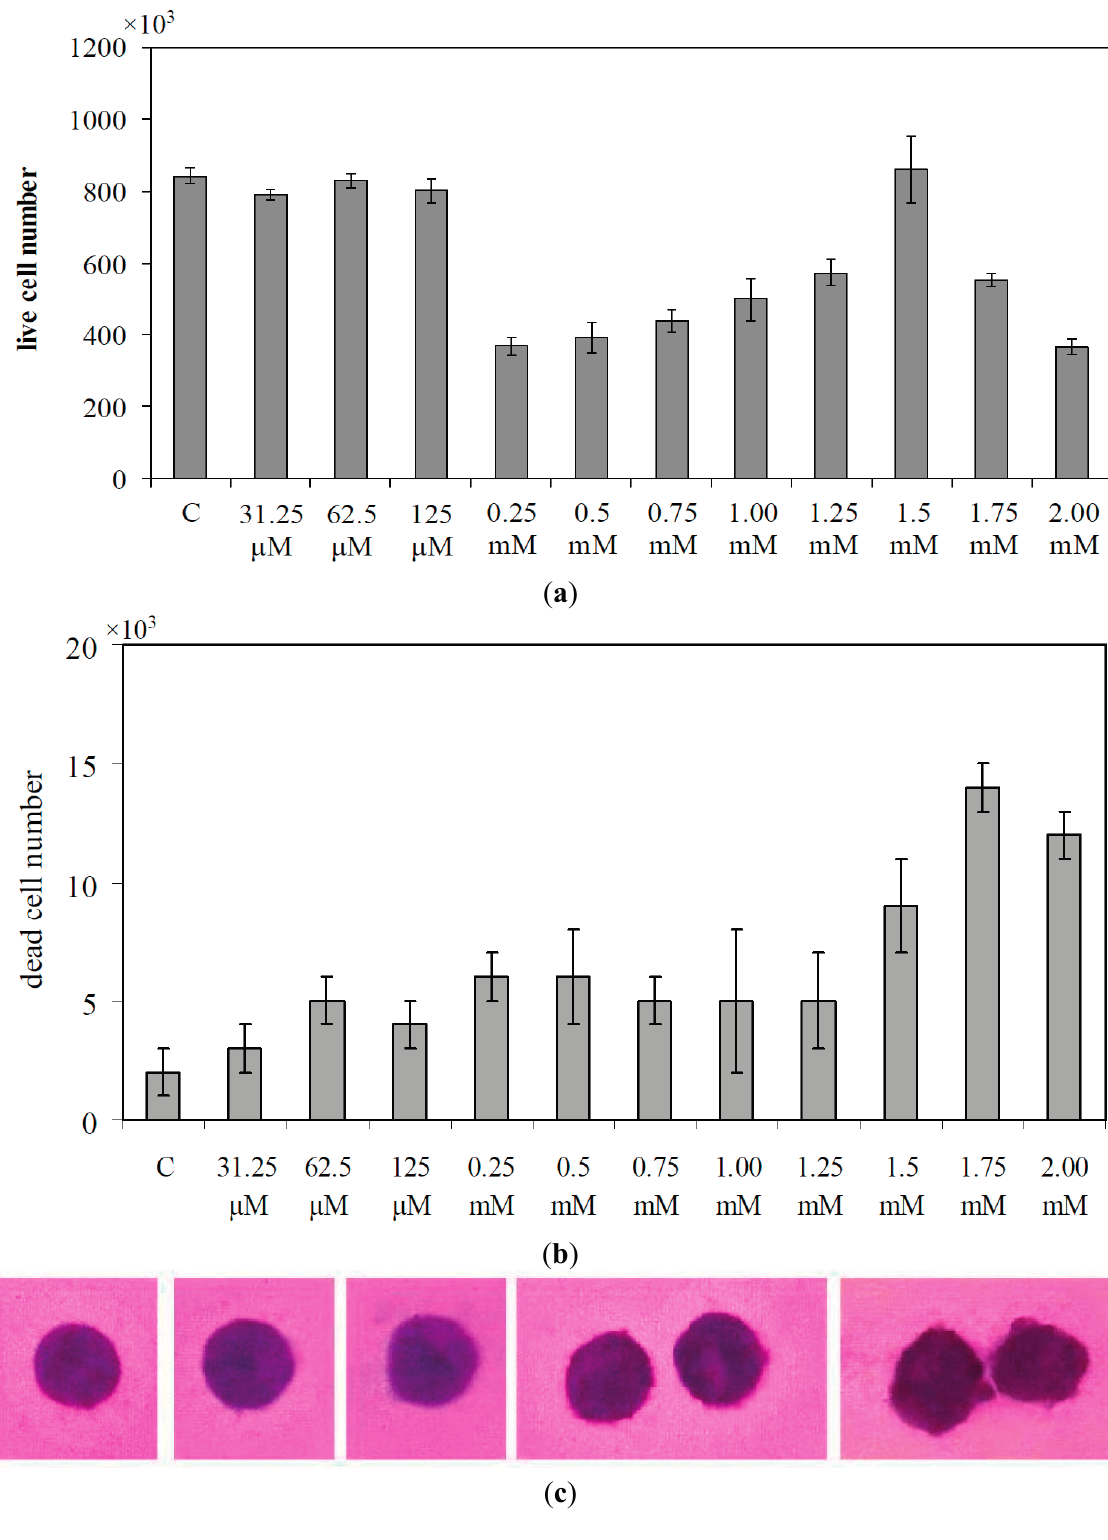
Figure 1. Effect of increasing doses of gentamicin on SUP-T1 cells. ( a ) The number of live cells; ( b ) The number of dead cells; and ( c ) Morphological changes. Data are expressed as the mean ± SD of three independent experiments performed in duplicate. C,